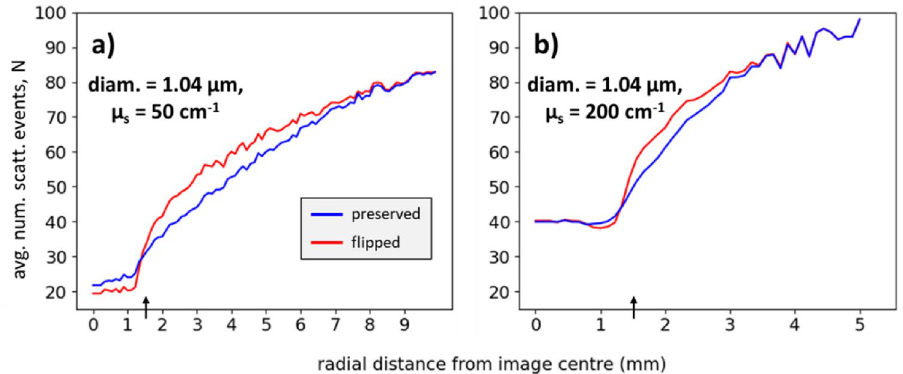
Figure 6. The average number of scattering events, N, for flipped and preserved photons as a function of radial distance from the centre of the simulation images of suspensions with 1.04 μm spheres at µ s = 50 cm −1 (left) and 200 cm -1 (right). There is an interesting reversal at the IR boundary whereby flipped photons switch